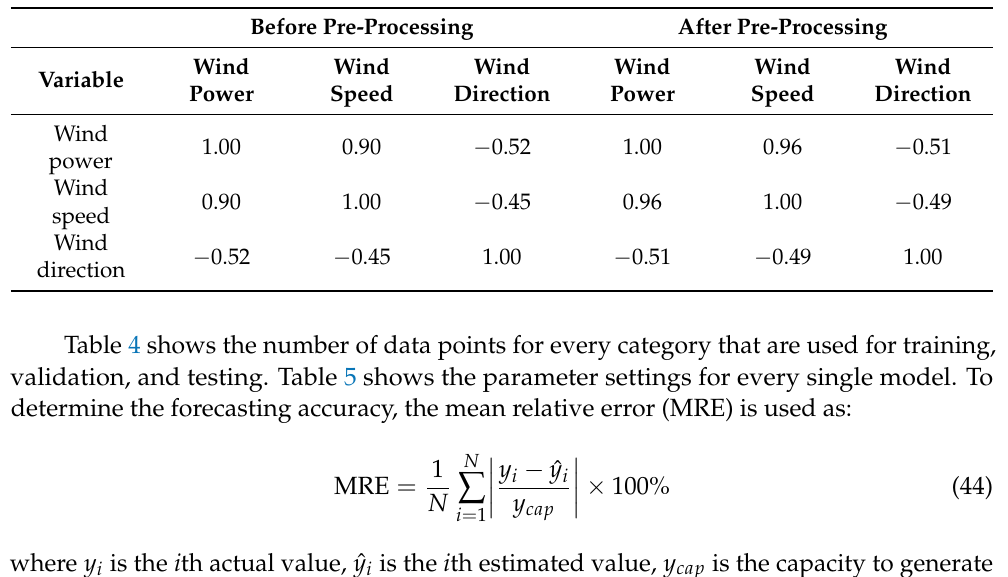
Table 3. Pearson correlation coefficient values between weather variables and wind power.